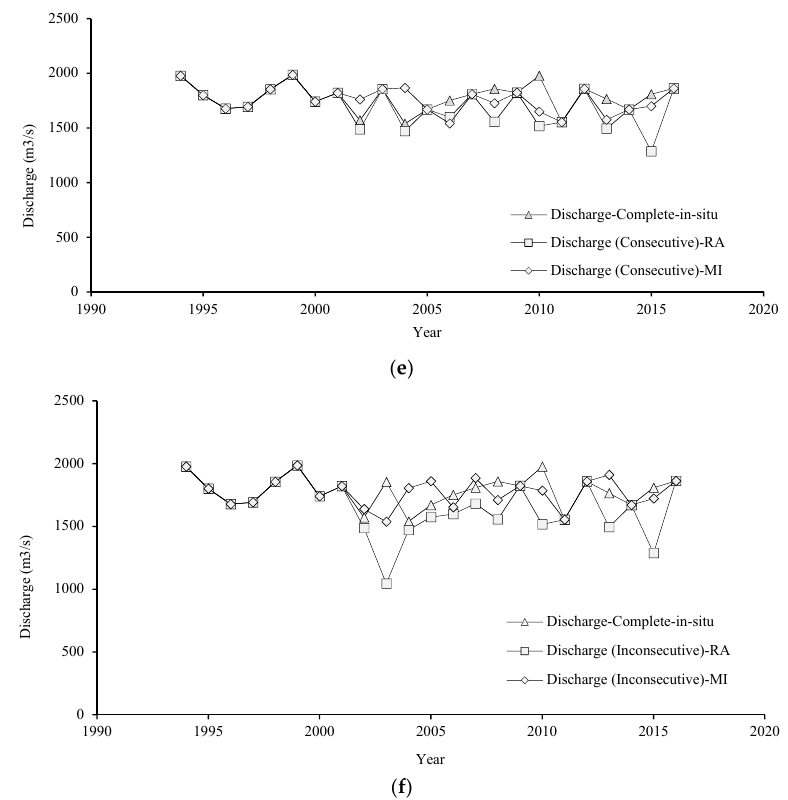
Figure 3. ( a ) Baro station in situ and MI and RA infilled time series. ( b ) Lokoja station in situ and MI and RA infilled time series. ( c ) Umaisha station in situ and MI and RA Infilled time series. ( d ) Onitsha station in situ and MI and RA infilled time series. ( e ) Taoussa original complete time series and time series with consecutive missing data filled using MI and RA. ( f ) Taoussa original complete time series and time series with inconsecutive missing data filled using MI and RA.